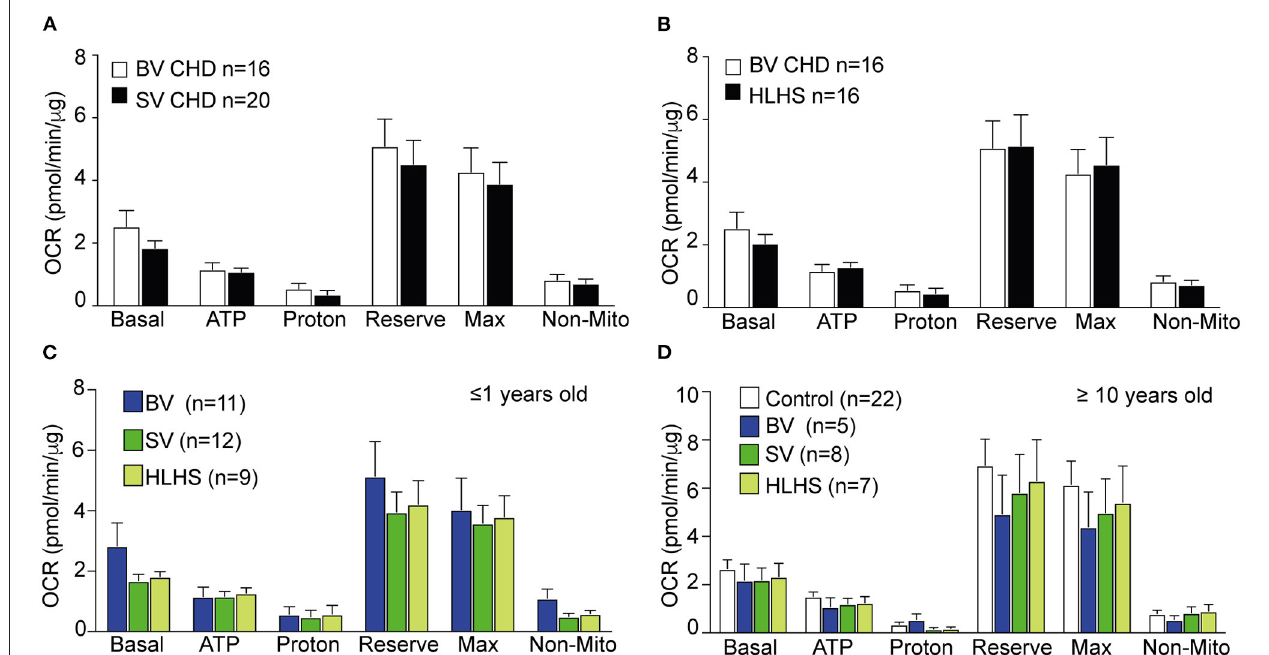
FIGURE 1 | Comparison of mitochondrial respiration in the PBMCs of CHD patients stratified by lesion type, age, and Fontan status. (A,B) There was no difference in any of the respiratory parameters in OCR of PBMCs of BV-CHD vs. SV-CHD and between BV-CHD and HLHS. (C) No significant difference was observed in the parameters of mitochondrial respiration among BV-CHD, SV-CHD, and HLHS patients ≤ 1 year old. (D) No significant difference in mitochondrial respiration was observed among control, BV-CHD, SV-CHD, and HLHS subjects ≥ 10 years old. Bar graphs show mean ± SEM with one-way ANOVA. Subjects’ numbers were indicated in the graphs. BV, biventricular; CHD, congenital heart disease; HLHS, hypoplastic left heart syndrome; OCR, oxygen consumption rate; PBMC, peripheral blood mononuclear cell; SV, single